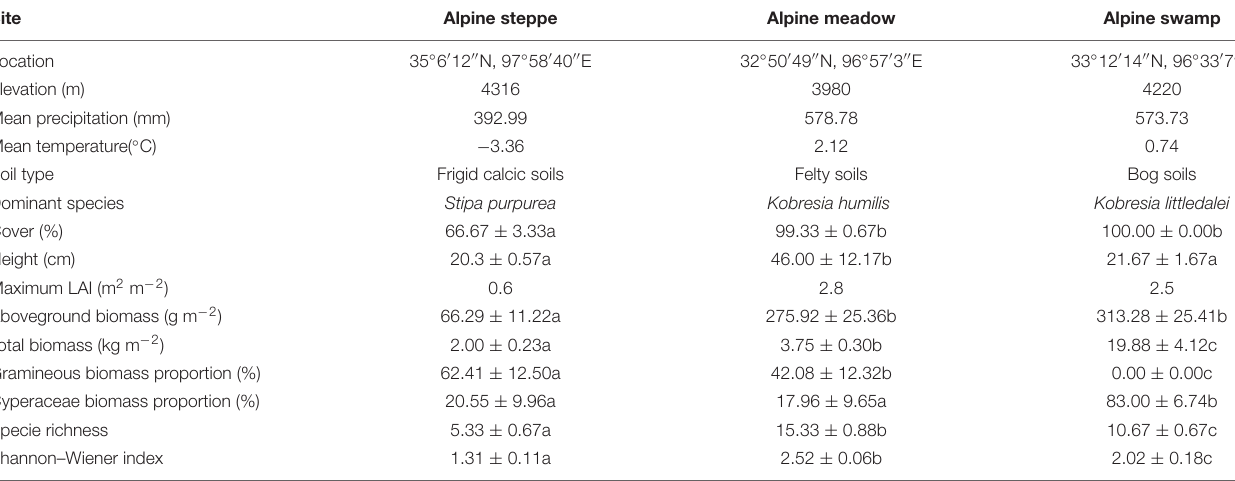
TABLE 1 | Site information and community characteristics of the three grassland ecosystems on the Qinghai–Tibetan Plateau. Site Alpine steppe